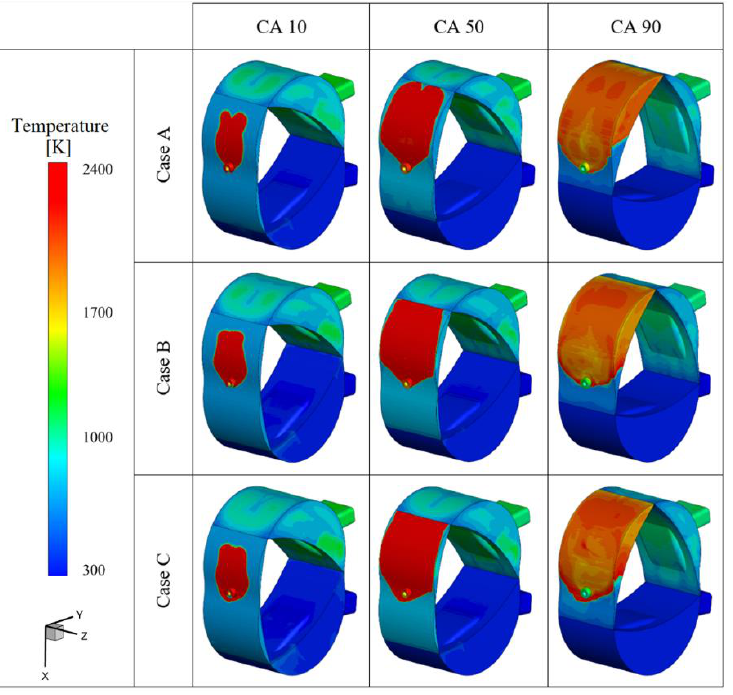
Figure 12. Temperature distribution for different cases at CA 10, CA 50 and CA 90.